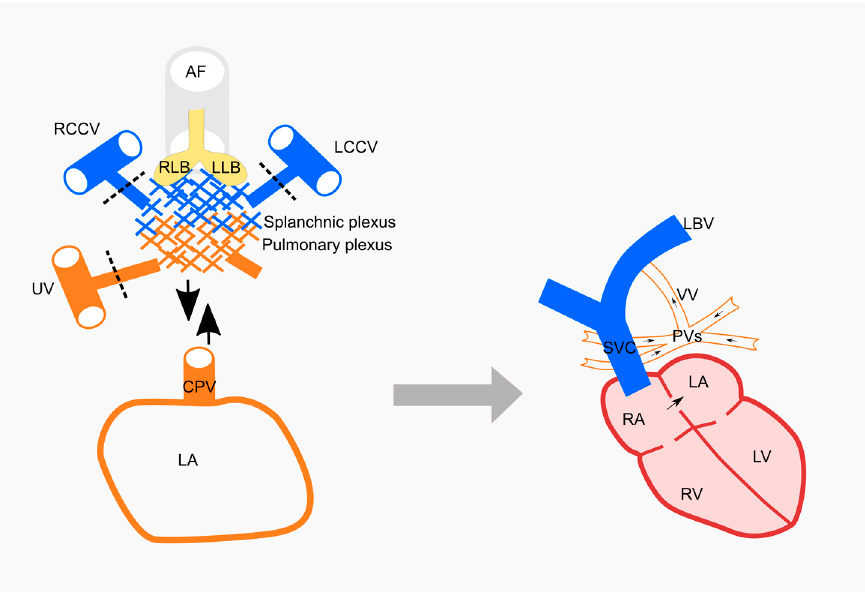
Figure 3. Type I = supracardiac of total anomalous pulmonary venous return (TAPVR) results from failure to establish a normal connection between the pulmonary venous plexus and the common pulmonary vein and the connections with splanchnic venous system is not regressed. All the pulmonary veins drain to the right atrium by varied route. AF—anterior foregut; RLB—right lung bud; LLB—left lung bud; RCCV—right common cardinal vein; LCCV—left common cardinal vein; UV—umbilical vein; CPV—common pulmonary vein; LA—left atrium; LVB—left brachiocephalic vein; VV—vertical vein; PVs—pulmonary veins; SVC—superior vena cava; RA—right atrium; RV—right ventricle; LV—left ventricle.